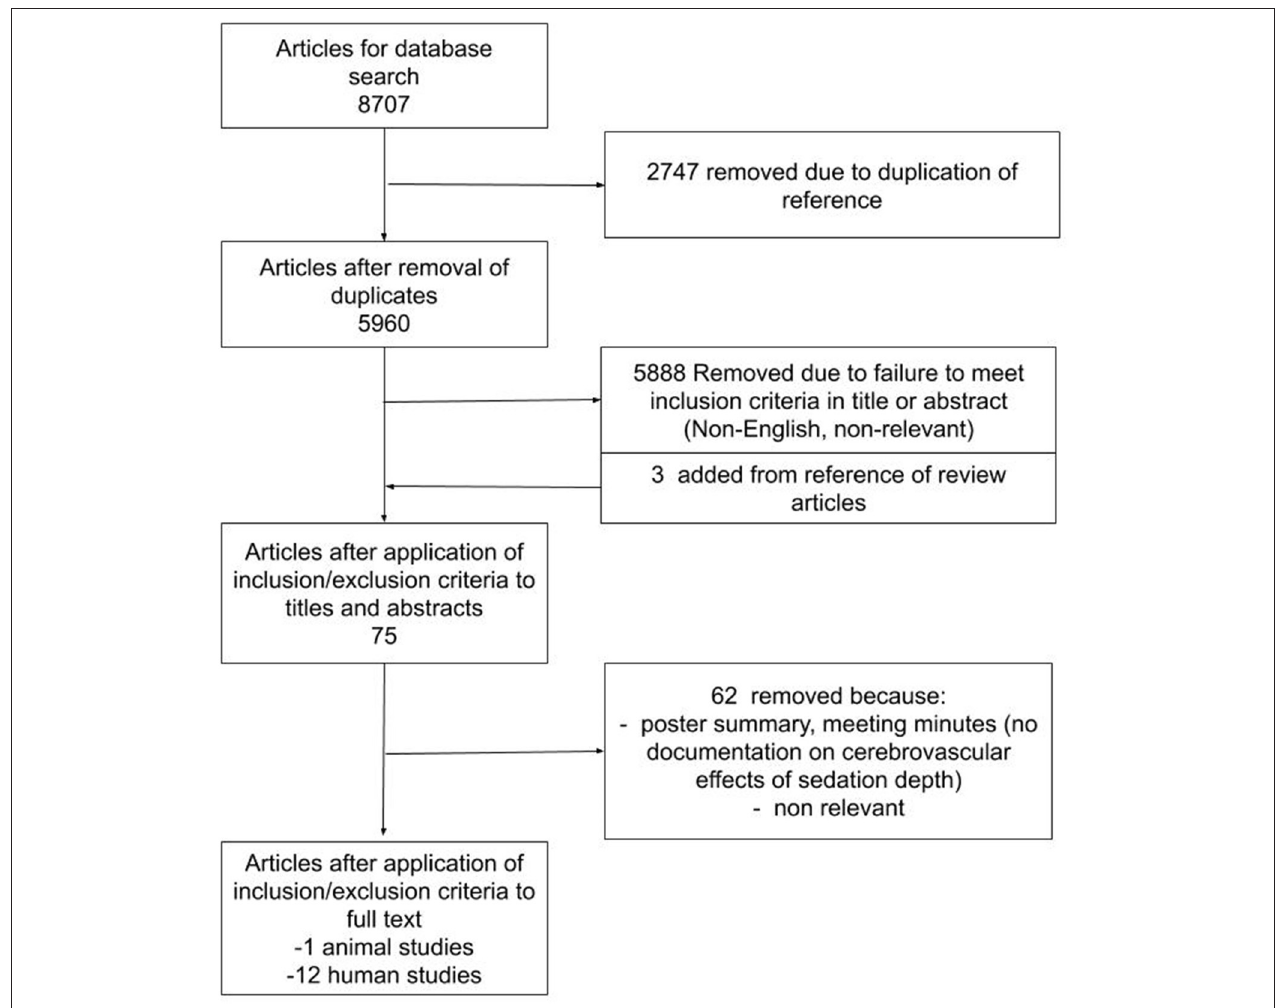
FIGURE 1 | PRISMA Flow Diagram. PRISMA, Preferred Reporting In Systematic Reviews and